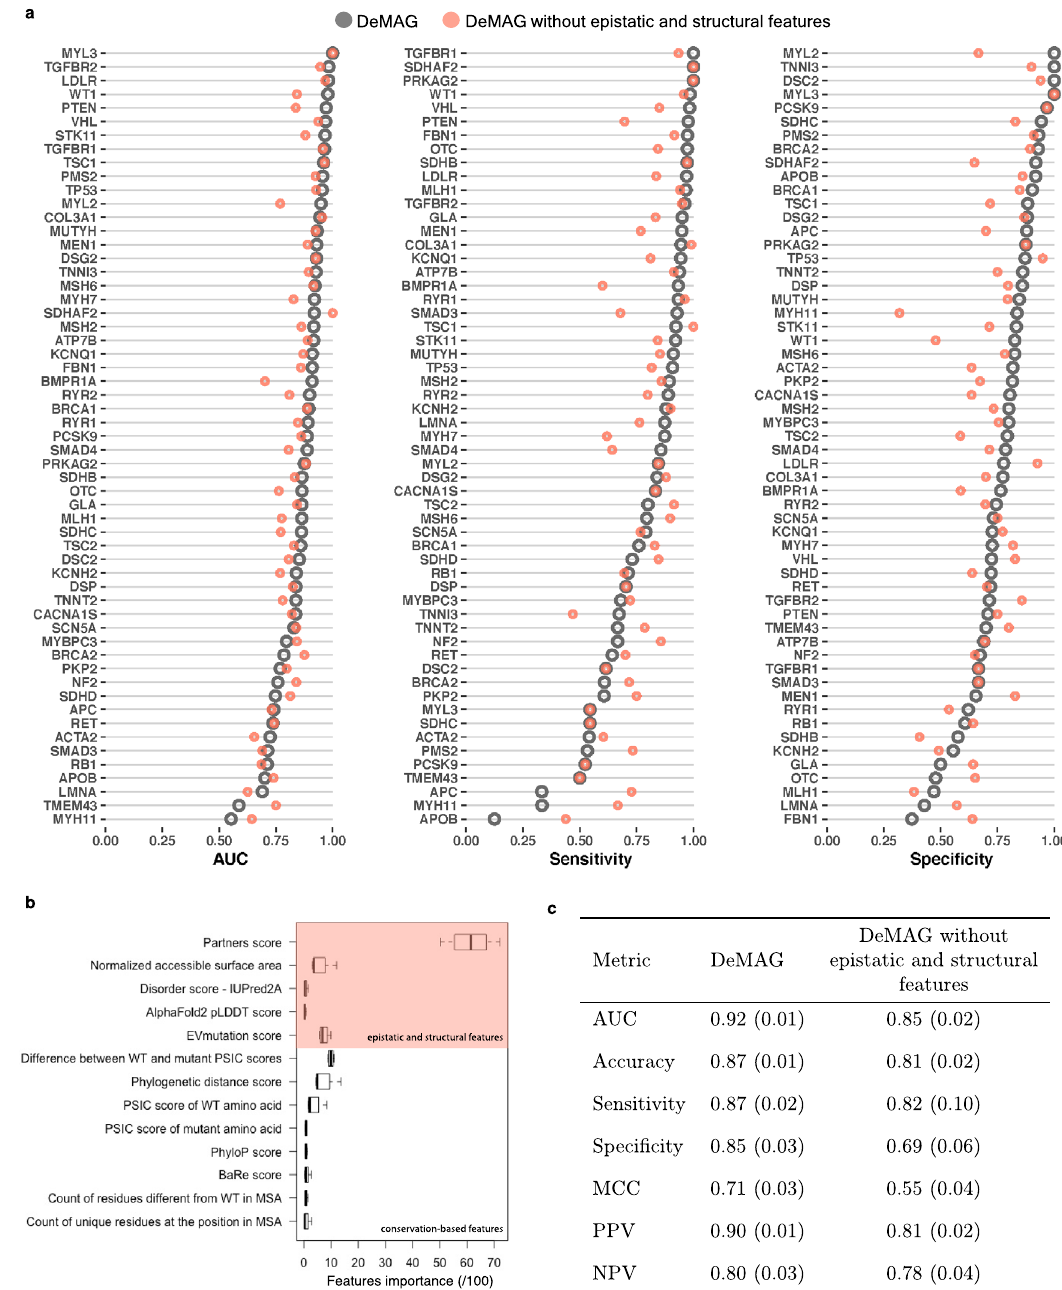
Fig. 4 | Epistatic and structural features improve DeMAG performance, both withinandacrossgenesinthetrainingset.a Performancewithingenes:formost genes, variants are classi fi ed with high ROC-AUC>70%. The high performance is also maintained for the classi fi cation of pathogenic (sensitivity >70%) and benign (speci fi city >70%) variants in most genes. b The feature importance of the 13 DeMAG features averaged across n =4 cross validation (CV) folds (see Supple- mentary Table 2 for features description). The whiskers of the boxplots range correspondto±1.5timestheIQR(interquantilerange).Thelower(upper)boundof